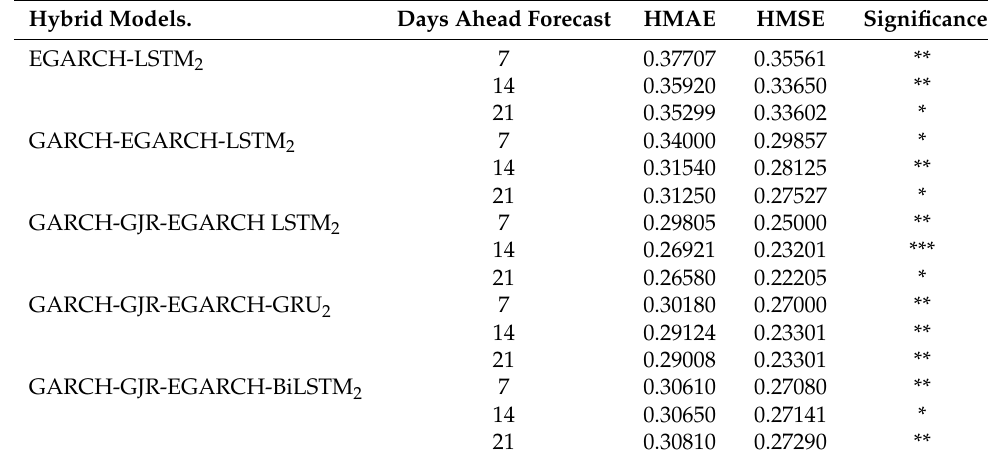
Table 7. Model confidence test (MCS) for significance across forecasting models. Hybrid